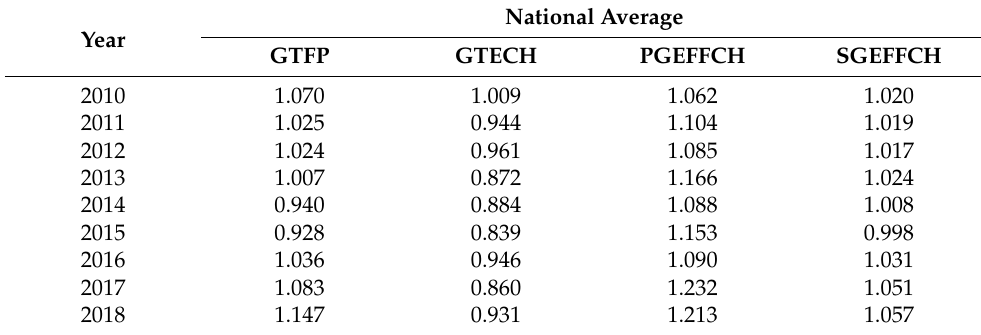
Table 3. National average values of GTFP and its composition.